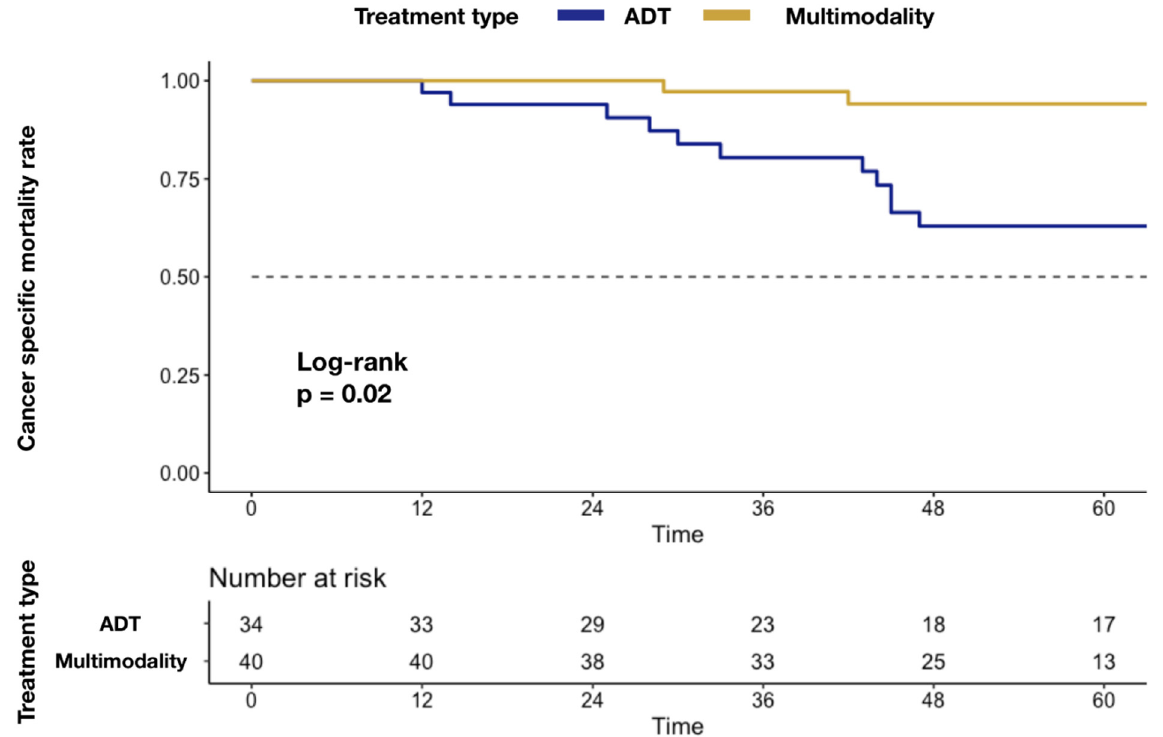
Figure 1. Kaplan–Meier plots depicting differences in CSM rate after stratification according to MMT vs. ADT alone. Abbreviations: cancer specific mortality (CSM); androgen deprivation therapy (ADT); multimodality treatment (MMT); metastatic castration-resistant prostate cancer (mCRPC). Similarly, higher mCRPC (24.0 vs. 62.5%; p < 0.01; Figure 2) and second-line systemic therapy (33.3 vs. 62.5%; p < 0.01; Figure 2) rates were recorded in the ADT group relative to MMT. Conversely, no statistically significant difference was recorded for disease progression, when MMT was compared to the ADT group (83.1 vs. 62.5%; p = 0.8; Figure 2). At MCRMs adjusted for the site of metastasis (Table 2), ADT-alone delivery